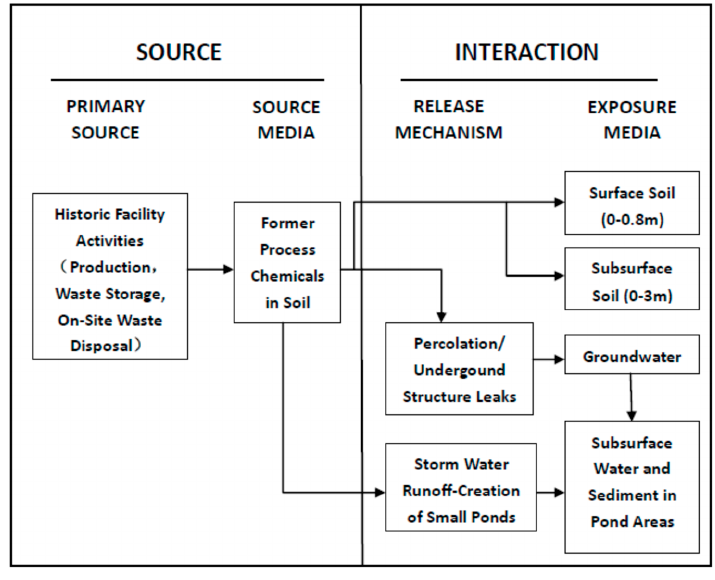
Figure 3. Source-Pathway-Exposure Model for Soil at the Luhe site.